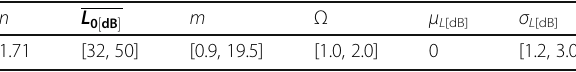
Table 9 Overview of the lognormal fit for body shadowing component in scenario S7, for typical MPL fit approach ( χ 2 Channel/ Body Sample size Parameters LogLH Polarisation